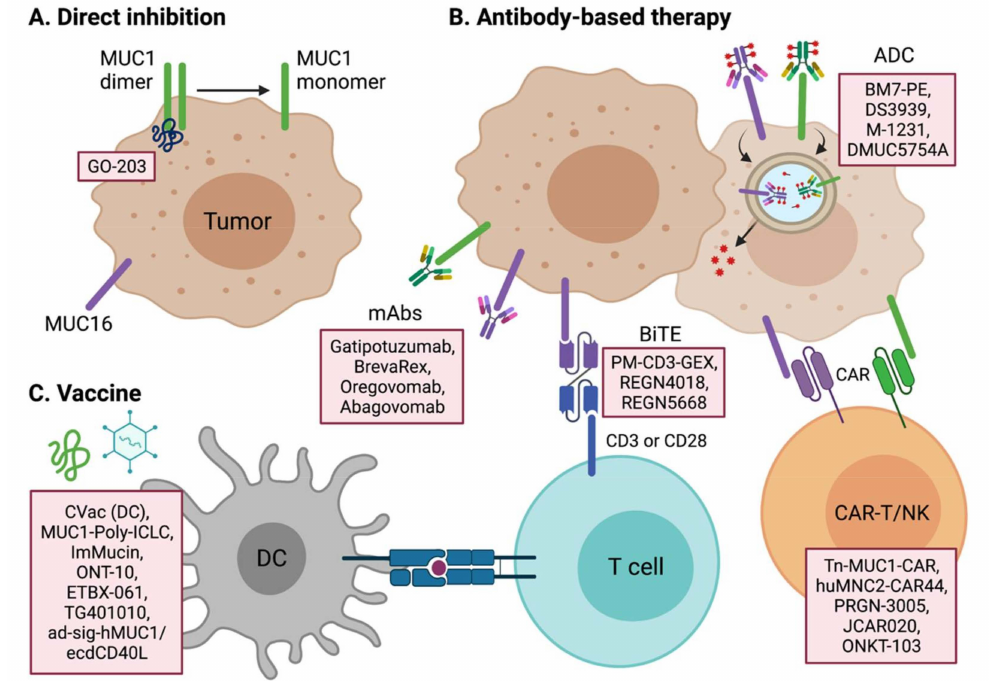
Figure 4. Anti-cancer therapeutic candidates that target MUC1 and MUC16. The aberrant expression of MUC1 and MUC16 in tumors provides potential strategies for targeting these molecules to kill cancer cells. ( A ) The direct MUC1 inhibitor GO-203 is a cell-permeable peptide that binds and blocks MUC1-C. ( B ) The extracellular domain of mucin in cancer cells is a potential target for monoclonal antibody-based therapies. ADCs dump toxins into cancer cells through the endocytosis of MUC1- and MUC16-binding antibodies. BiTE can recruit CD3+ or CD28+ cytotoxic T lymphocytes to MUC1- or MUC16-overexpressing cancer cells. CAR-T or NK cells directly kill cancer cells by recognizing MUC1 and MUC16 antigens. ( C ) Cancer vaccines elicit an active immune response by stimulating antigen-presenting cells (e.g., dendritic cells) against mucin protein